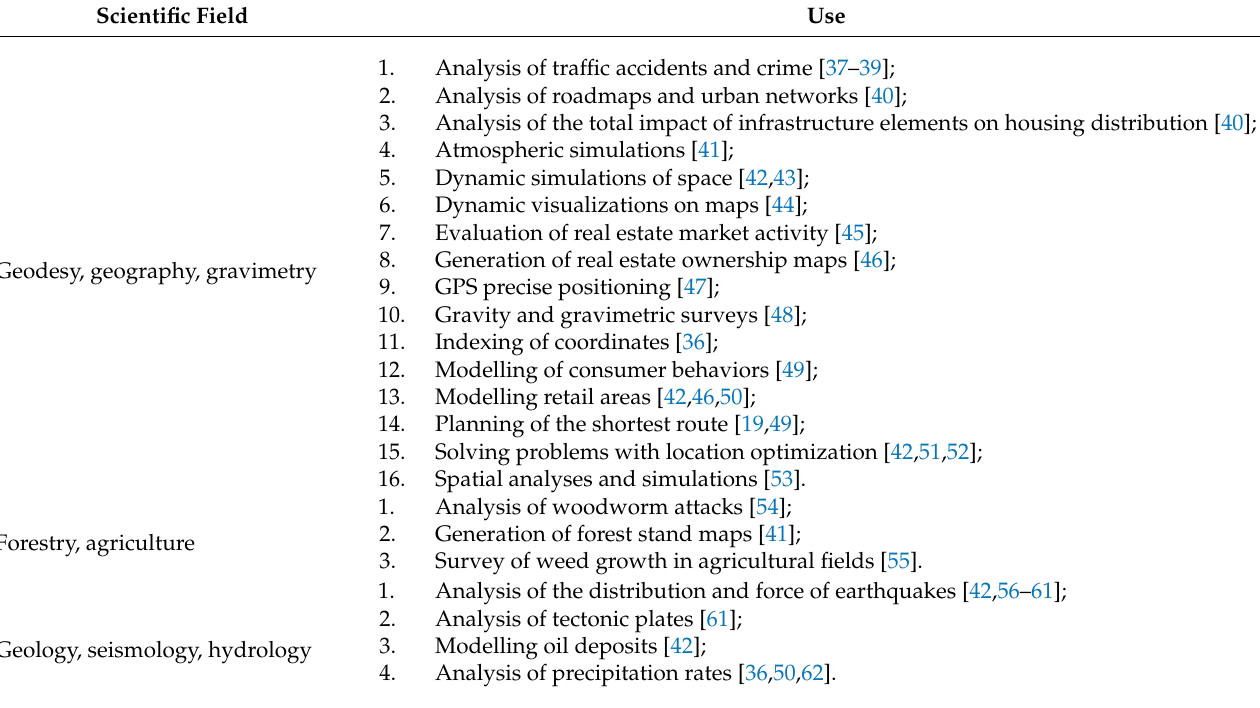
Table 1. Applicability of Voronoi diagrams in geosciences. Source: own